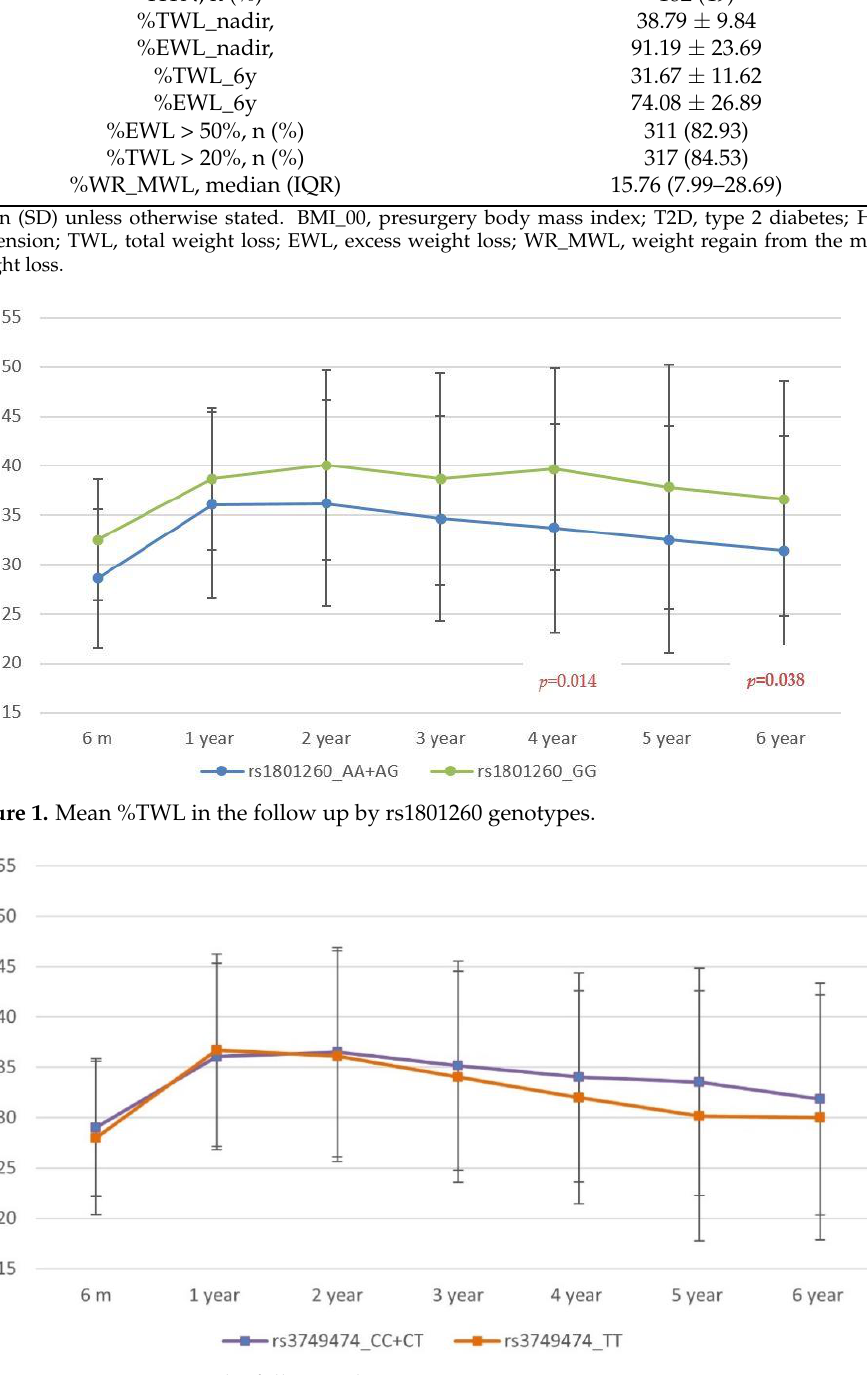
Figure 2. Mean %TWL in the follow up by rs3749474 genotypes. Table 3. Mean values of weight response variables by genotypes. Global cohort (N = 375).